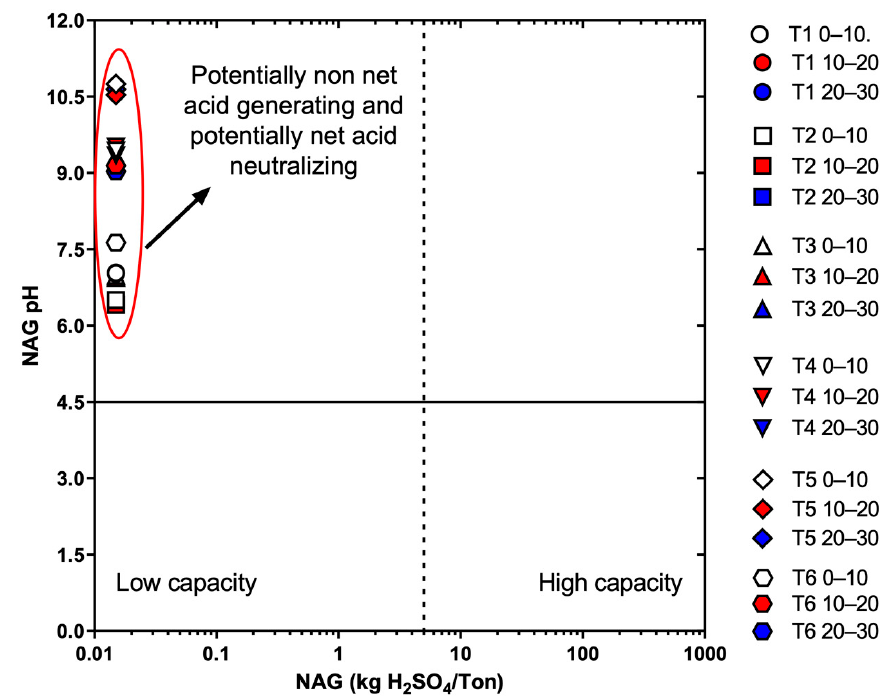
Figure 4. Evaluation of the net acid generation potential with the NAG test. NAG pH values are shown on a linear scale and NAG values on a logarithmic scale. On the abscissa axis, the tailings samples are represented referentially in a NAG value of 0.015 (detection limit of the method).